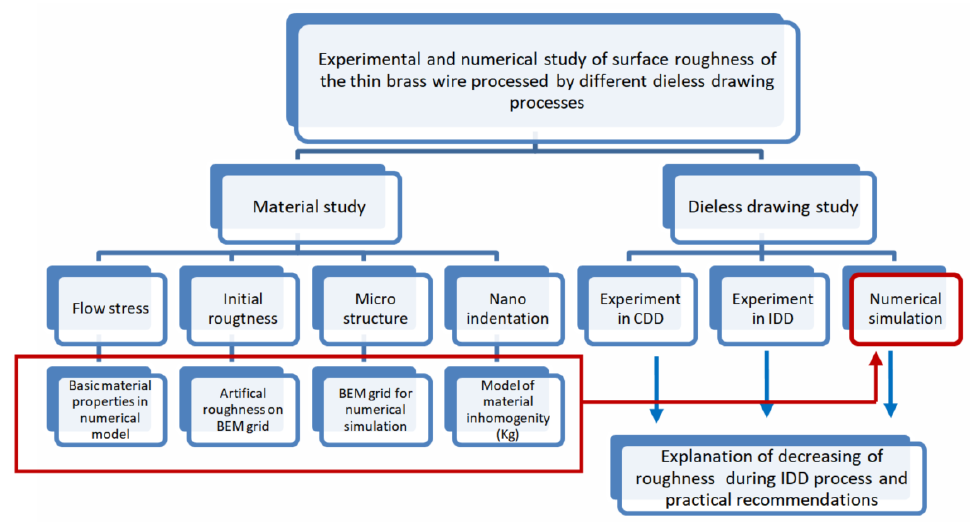
Figure 3. Overall flowchart of the research method.